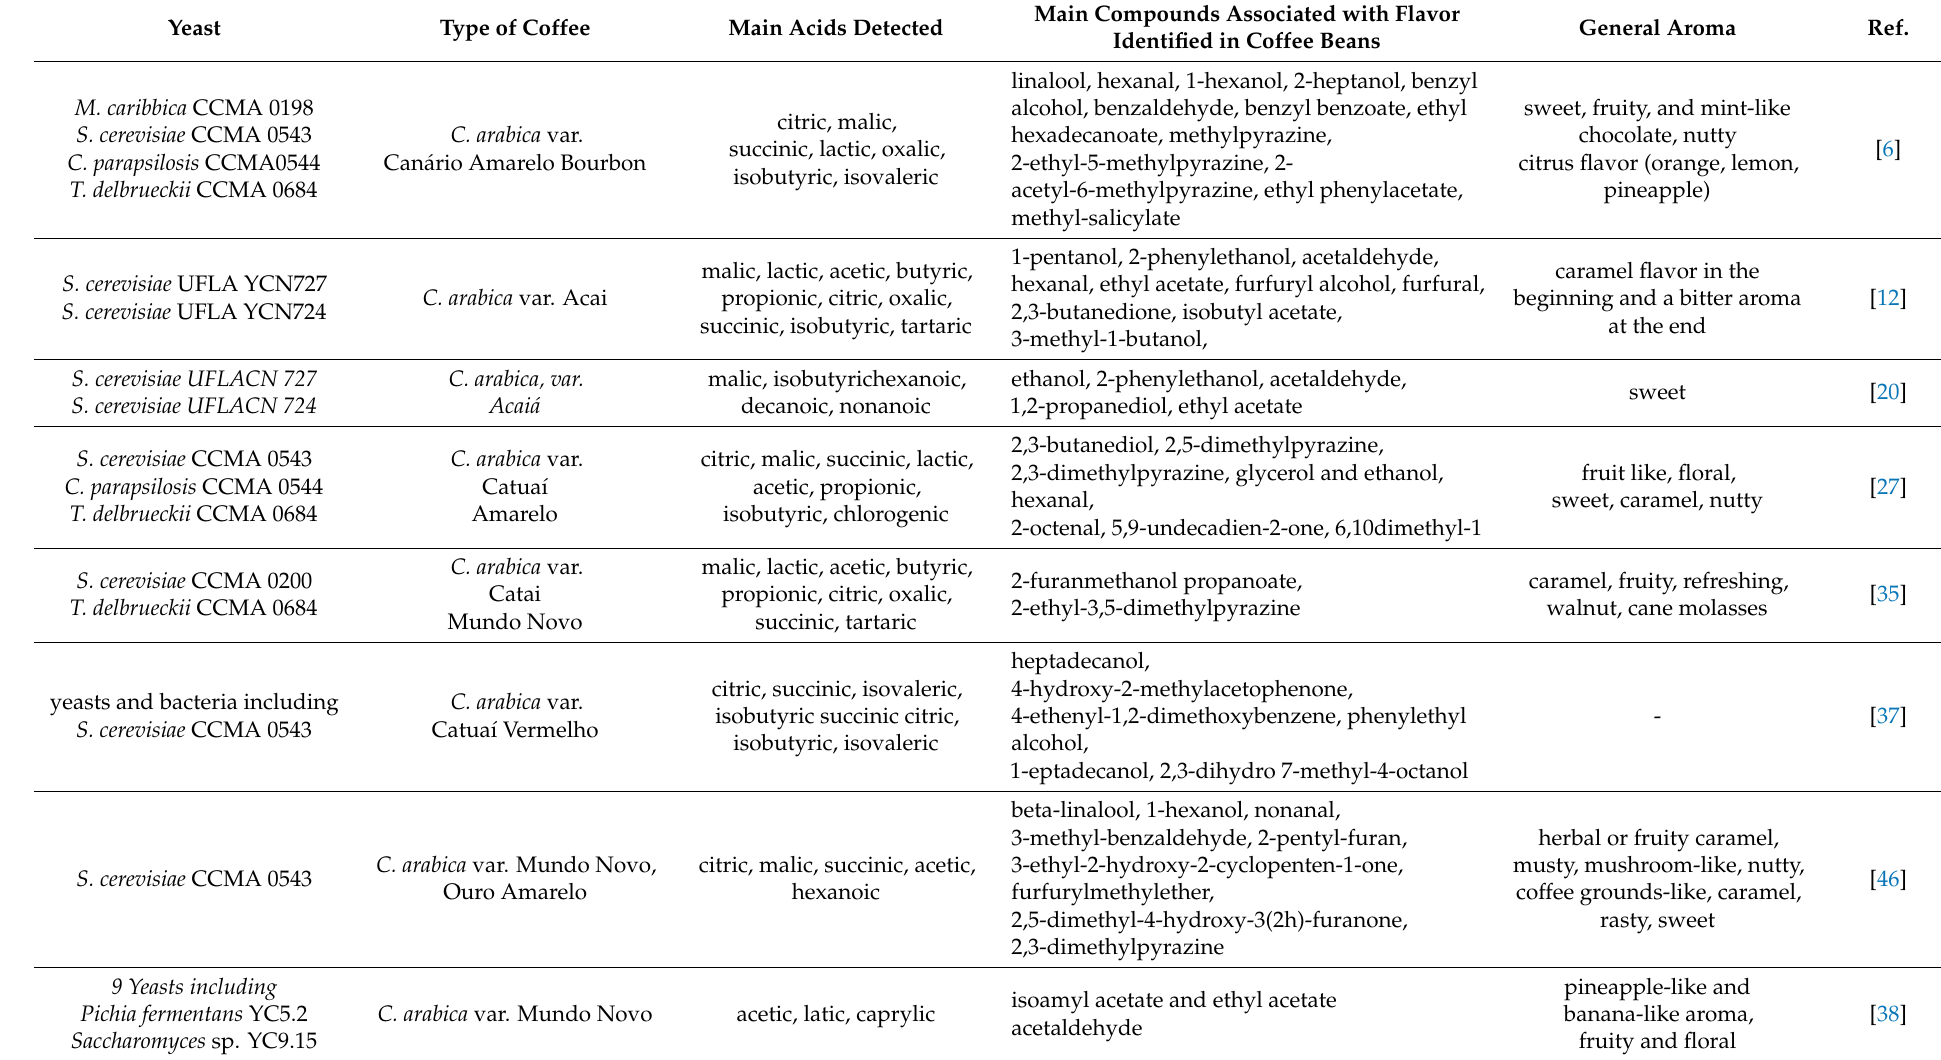
Table 1. Yeast strains used as starter inoculum in bean fermentation of coffee varieties and the main compounds in coffee associated with yeast fermentation.